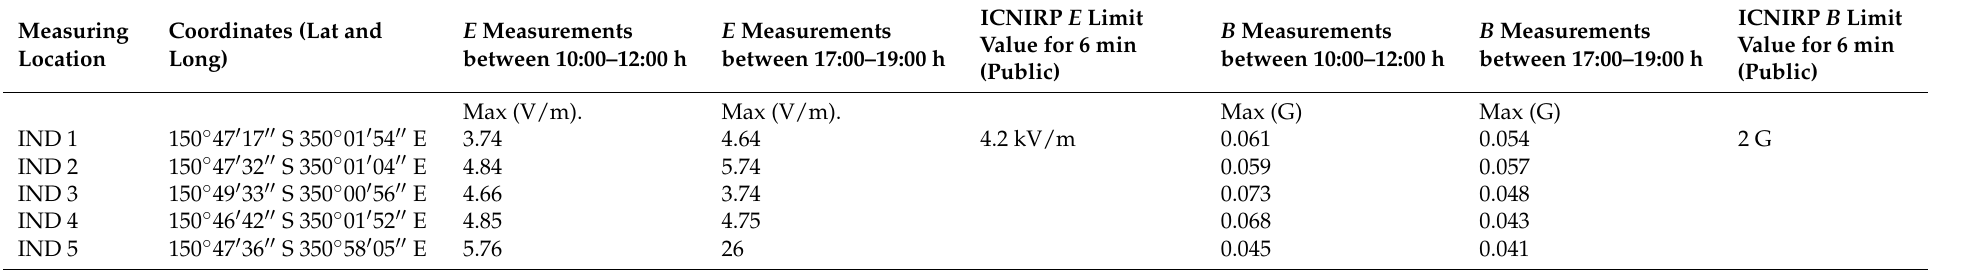
Table 6. Statistical results of E and B in industrial